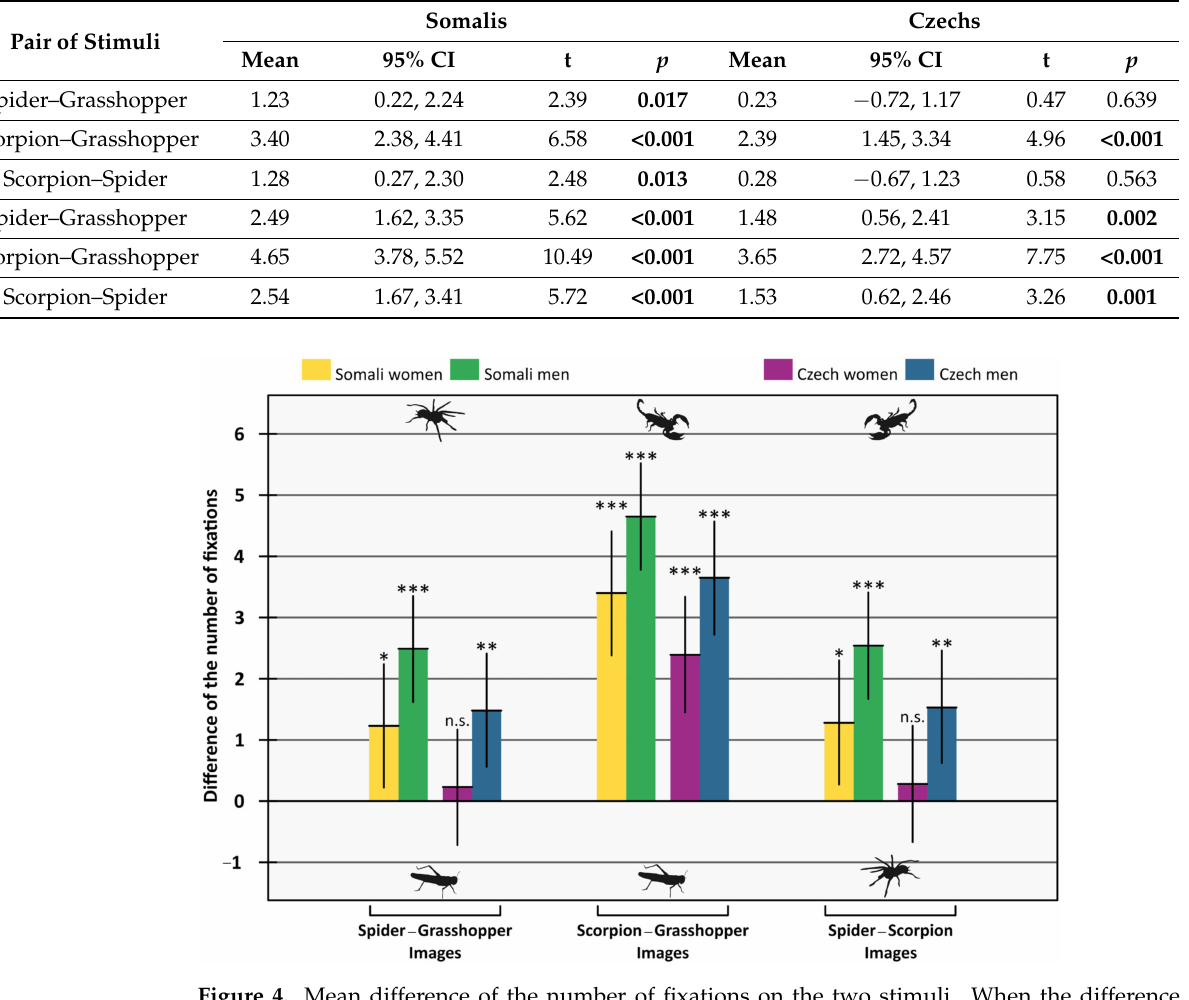
Figure 4. Mean difference of the number of fixations on the two stimuli. When the difference is positive, participants looked more on the first stimuli of the pair (e.g., in Spider − Grasshopper Images, participants looked more on the spiders). Error bars are 95% confidence intervals. Means are tested against zero, and significances are indicated by asterisks (n.s. p ≥ 0.05; * p < 0.05; ** p < 0.01; *** p <